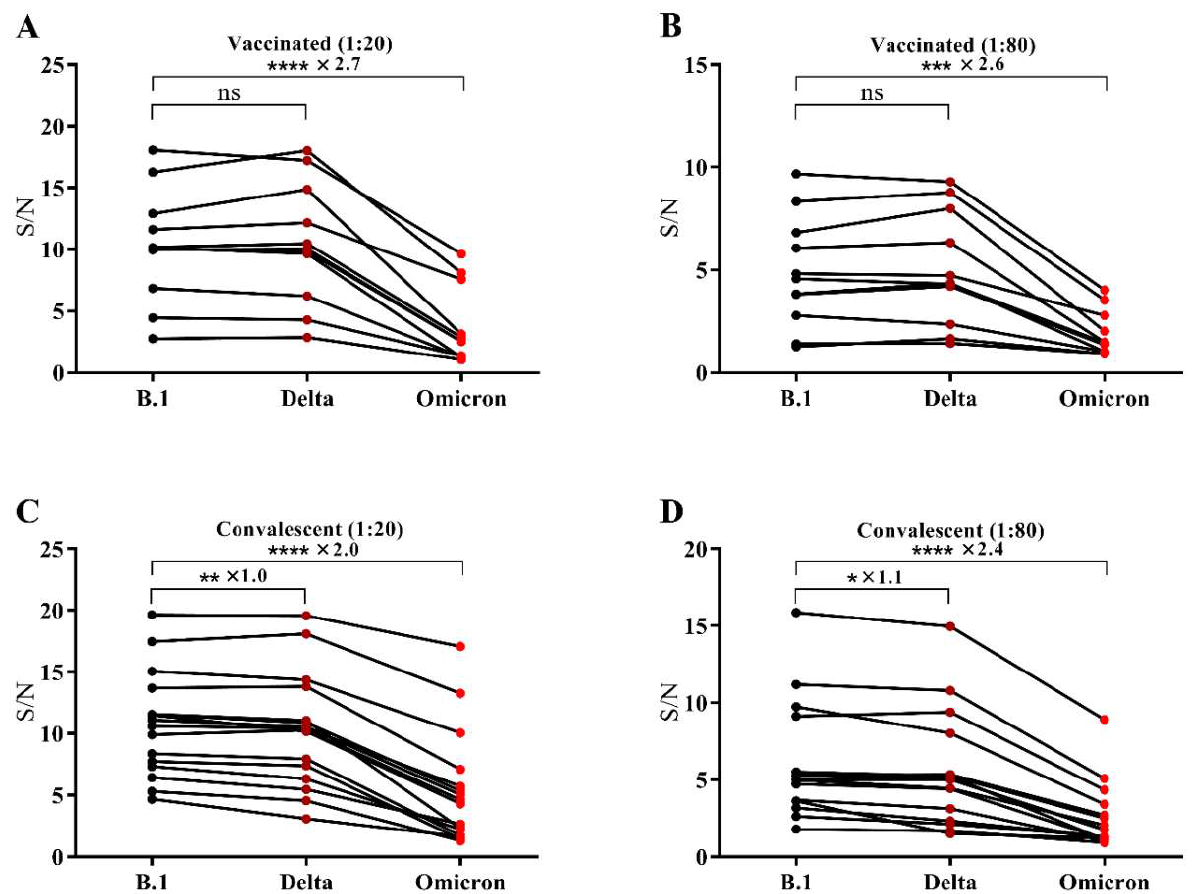
Figure 2. S/N values calculated from the data measured by a microplate reader at OD 450 nm of the vaccinated sera with the dilution of 1:20 ( A ) and with the dilution of 1:80 ( B ) and the convalescent sera with the dilution of 1:20 ( C ) and with the dilution of 1:80 ( D ). Data were paired-analysed by a one-way ANOVA with Dunn’s post-test; * p < 0.05, ** p < 0.01, *** p < 0.001, **** p < 0.0001, “ns” means “no